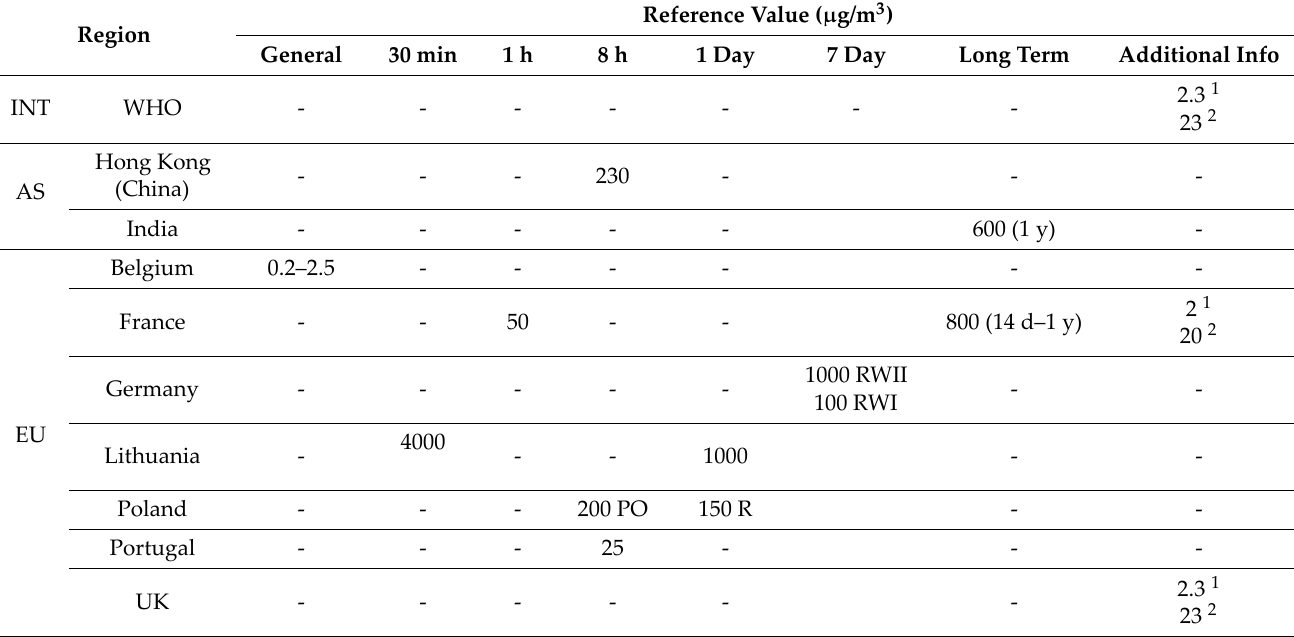
Table 21. Reference values for